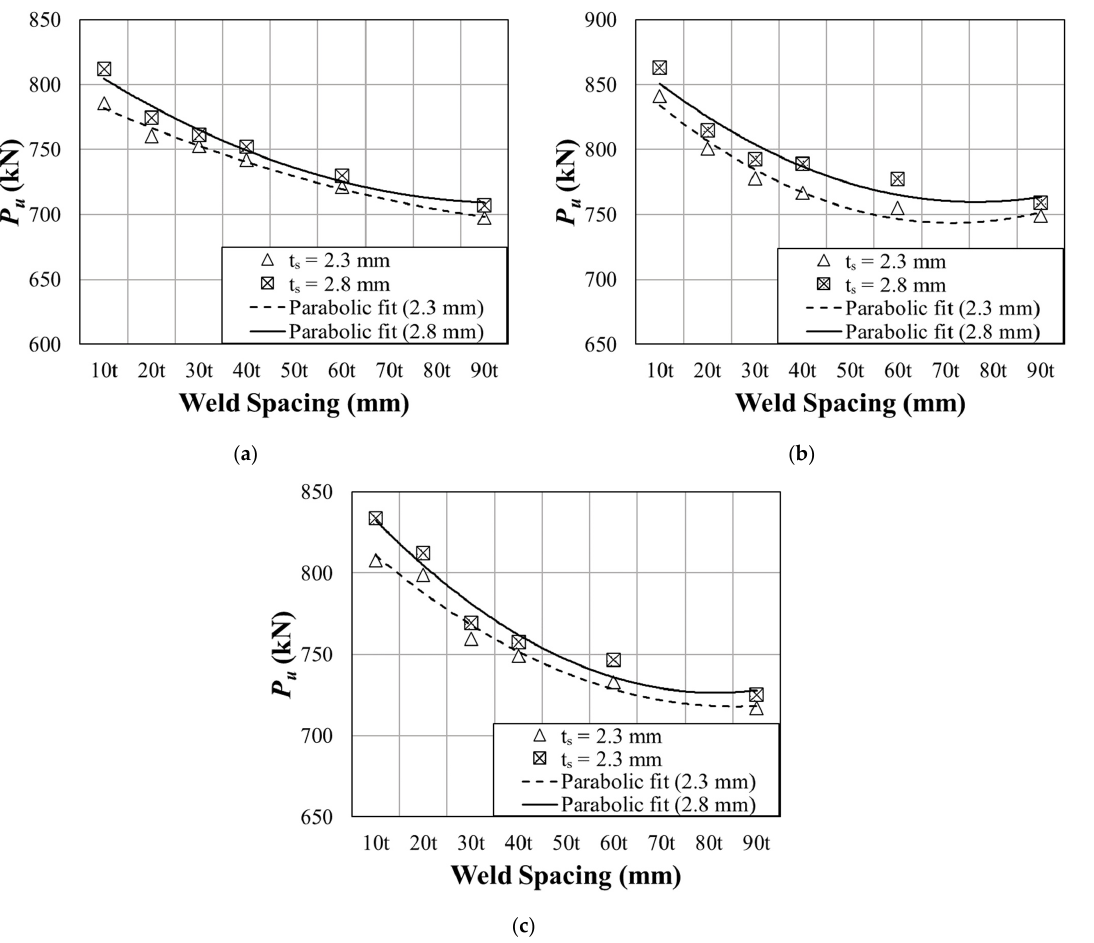
Figure 19. The effect of different stiffener thicknesses on the performance of the square CFDST . ( a ) b s = 12 mm, ( b ) b s = 18 mm, ( c ) b s = 25 mm.